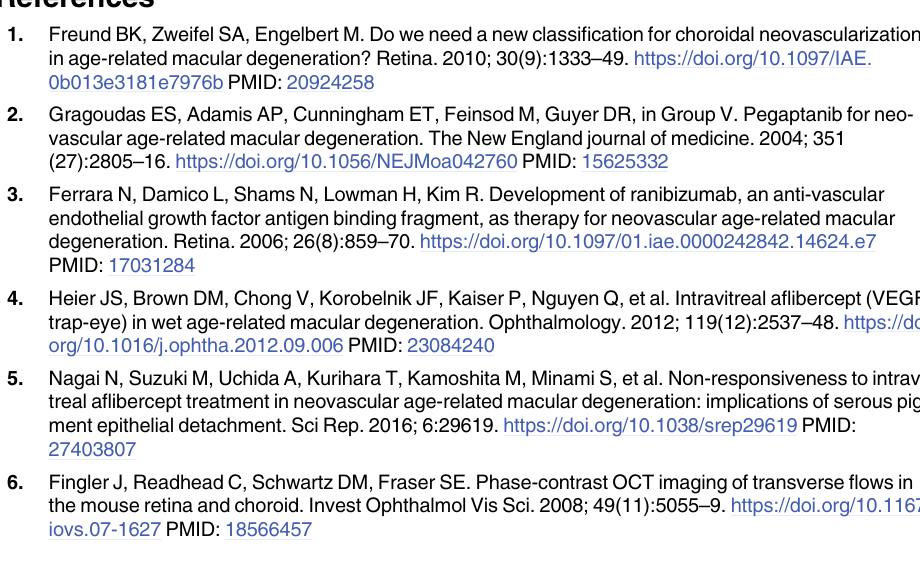
S1 Table. Original data including types of CNV, symptom duration, vessel area, vessel length, and vessel junction